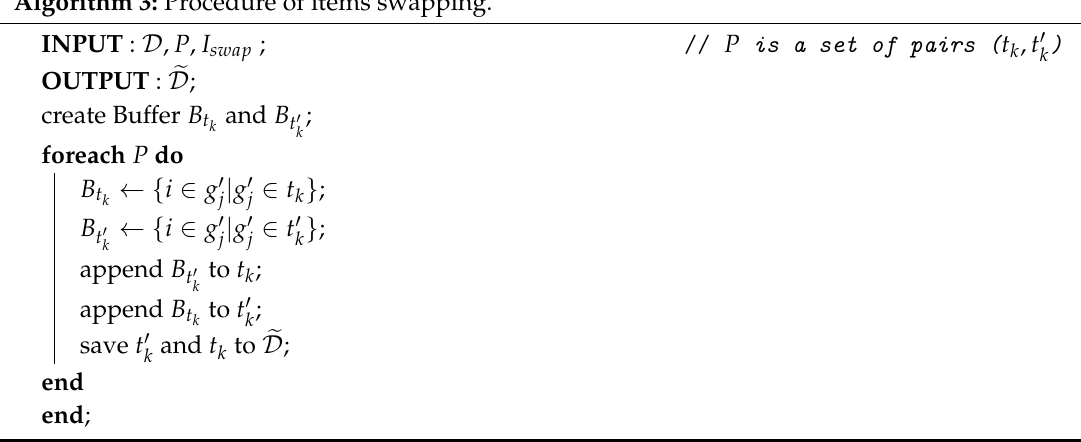
Algorithm 3: Procedure of items swapping.